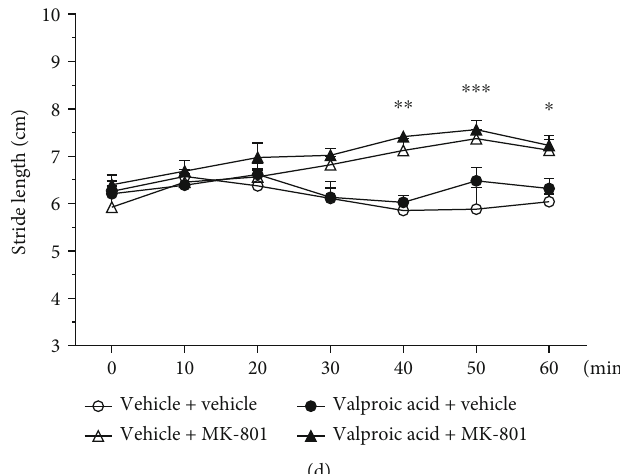
Figure 4: Behavioral di ff erences of gaiting, step angle (a, c), and stride length (b, d) followed by MK-801 injection for mice treated with risperidone/valproic acid. Statistically signi fi cant di ff erences between groups: ∗ p < 0 : 05 , ∗∗ p < 0 : 01 , and ∗∗∗ p < 0 : 001 vs. vehicle +vehicle. Vertical bars represent